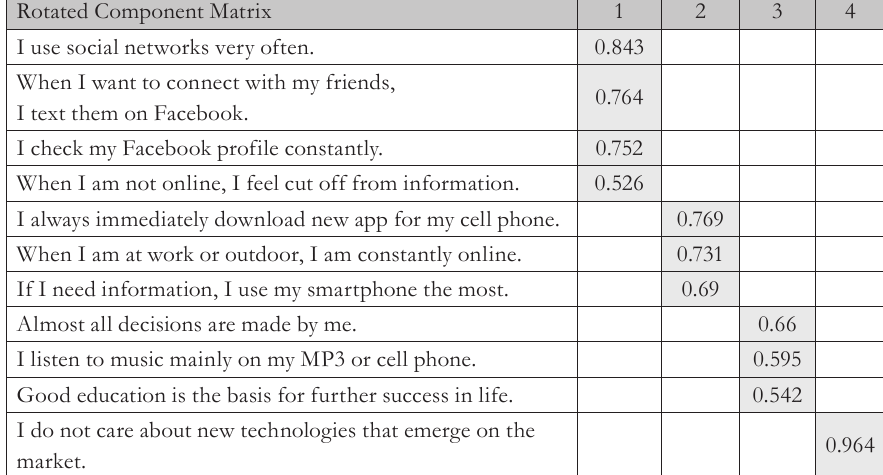
Tab. 3 – Factor Analysis of General Attitudes of Generation Y. Source: Author’s